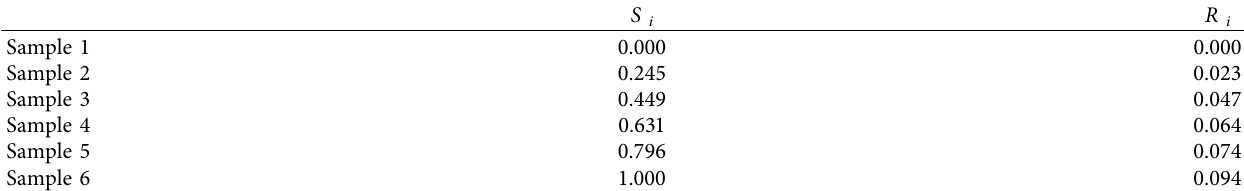
Table 12: Te R i and S i values of six typical samples.